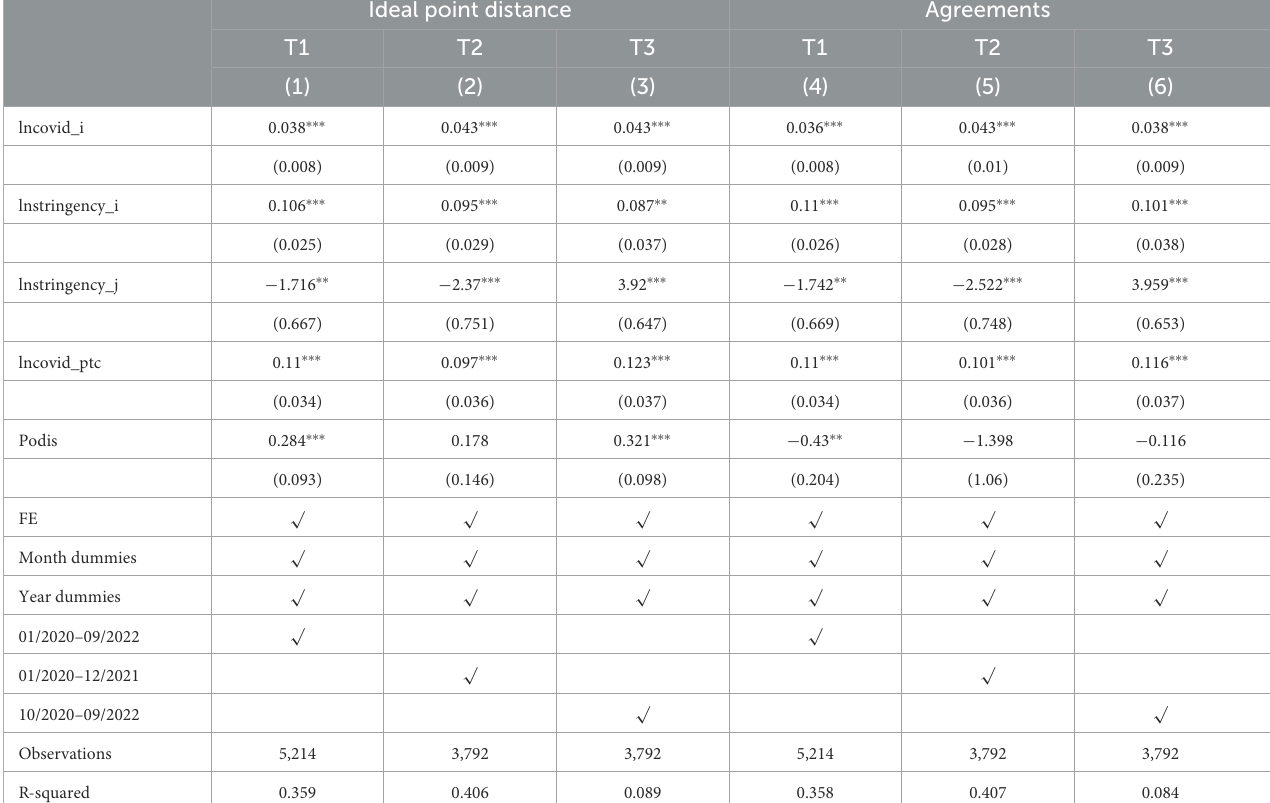
TABLE 6 Ideal point distance and